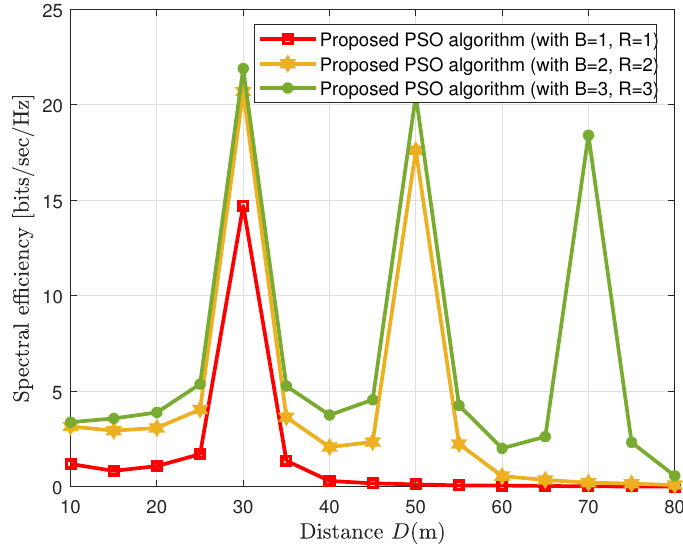
Figure 7. Impact of spectral efficiency on different RISs